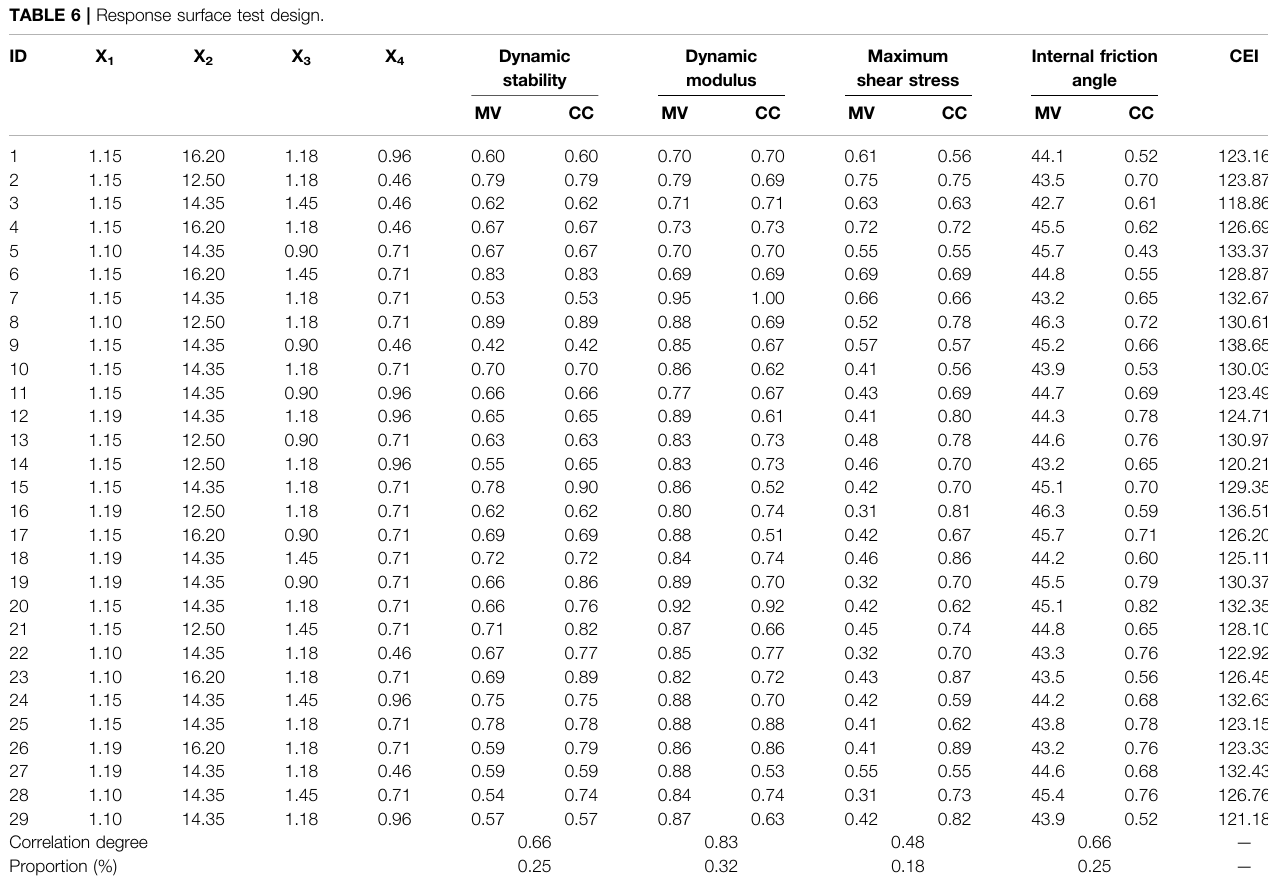
TABLE 6 | Response surface test